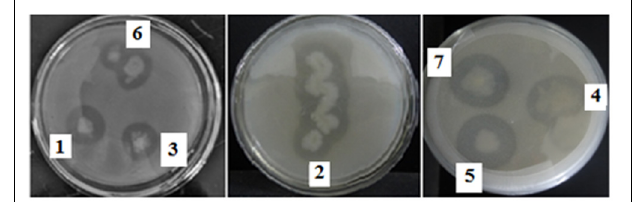
FIGURE 1 | Screening of Helicoverpa armigera midgut bacterial isolates for protease activity. Gut bacterial isolates were inoculated on agar plate containing skimmed milk casein and incubated for 24 h at 30 ◦ C. The clear zone around the inoculum indicated the hydrolysis of skimmed milk casein by the proteases secreted by gut bacteria.